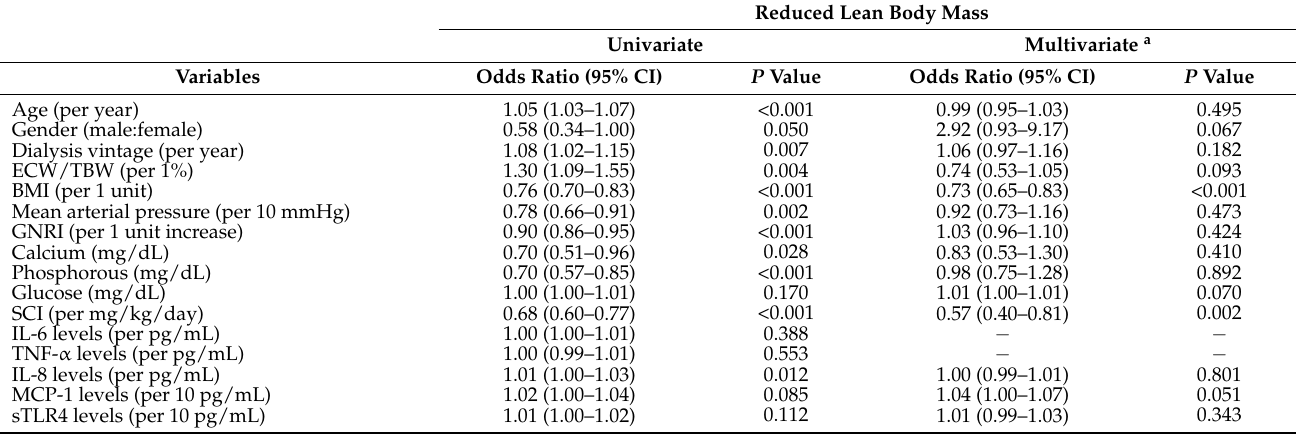
Table 3. Independent predictors for reduced lean body mass among hemodialysis